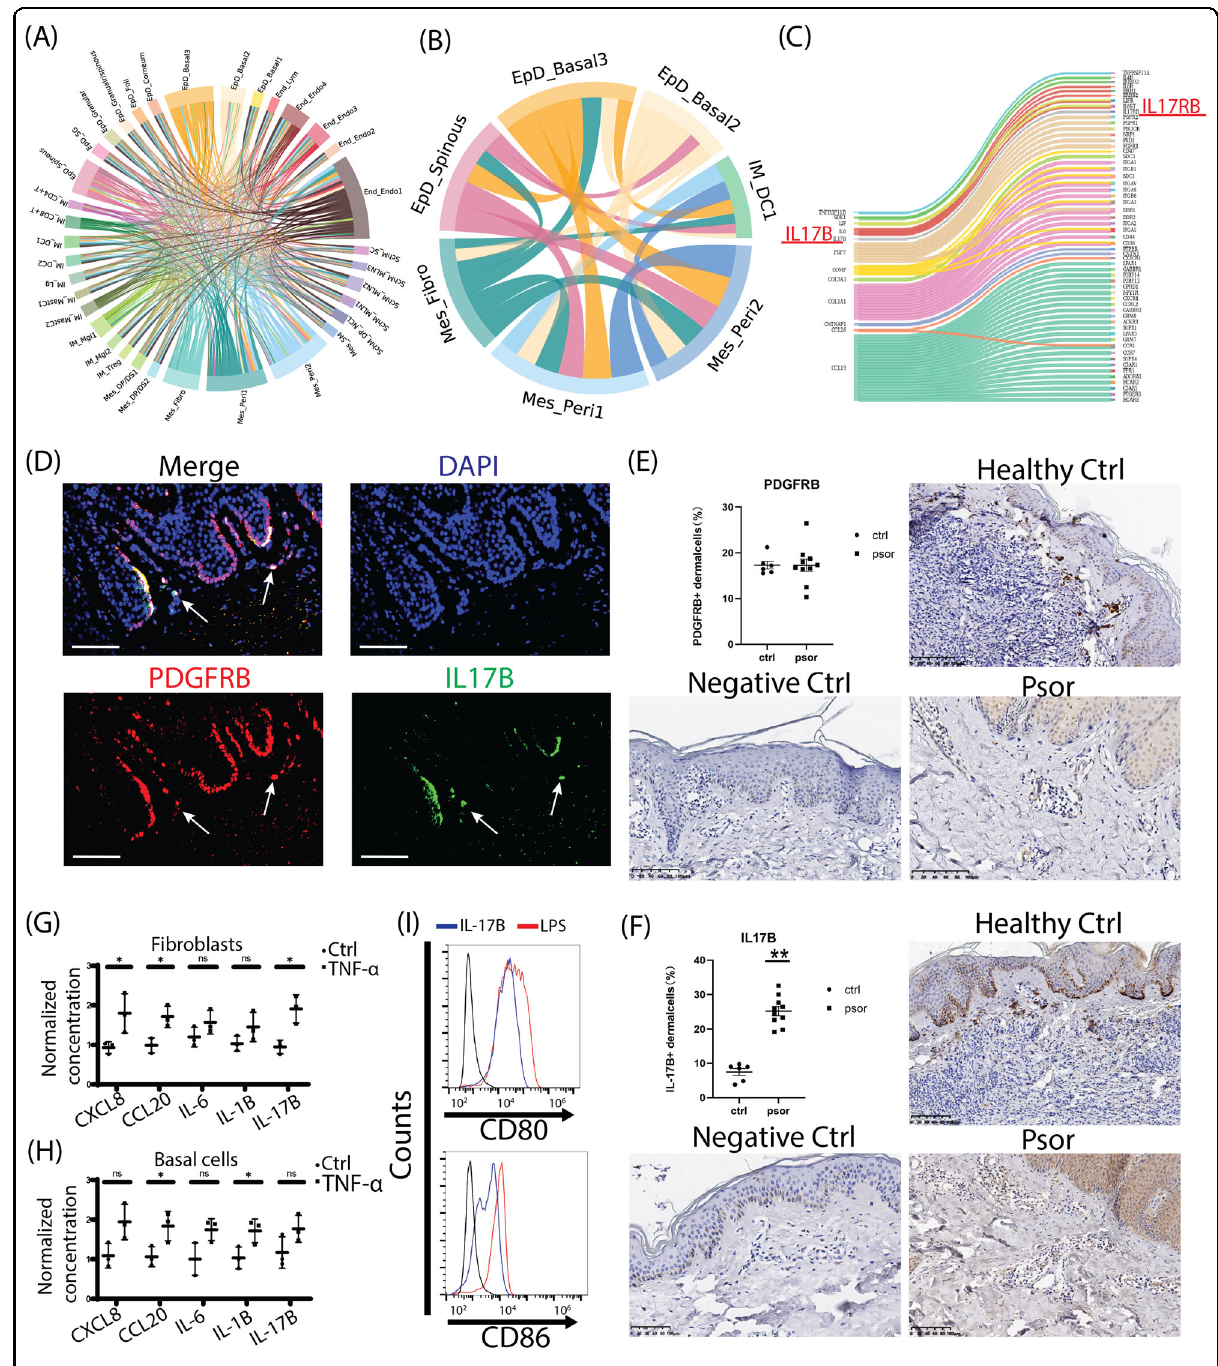
Fig. 4 (See legend on next